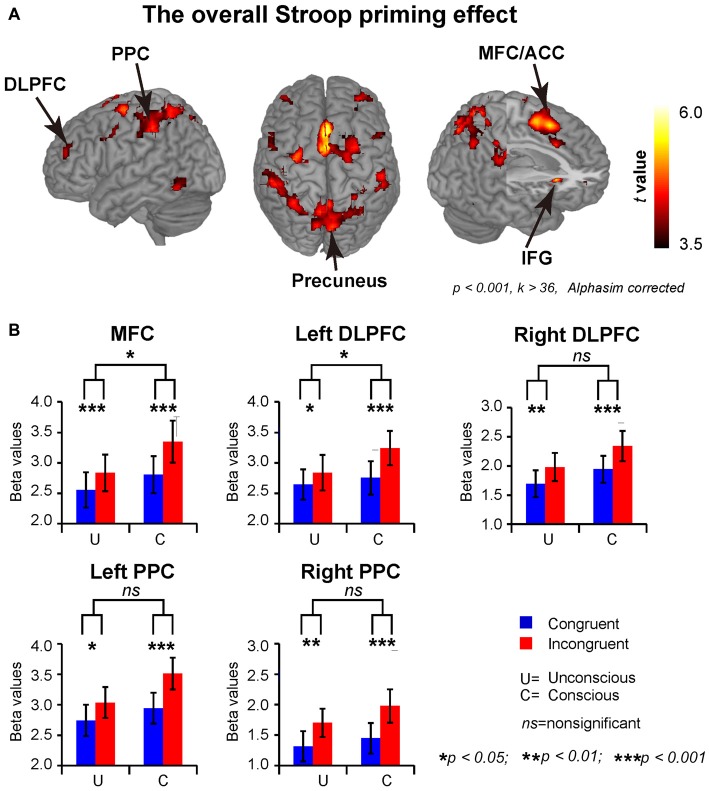
Brain regions showing significant activation of the overall Stroop priming effects. (A) The overall Stroop priming effects (Incongruent > congruent). The statistical thresholds were set at p < 0.001 with a minimum cluster size of 36 voxels using the AlphaSim Monte Carlo simulation. (B) The ROI analyses results. The Stroop prime effects were significant at MFC, left and right DLPFC, and the left and right PPC in both unconscious and conscious conditions, though the activations in conscious condition were stronger at MFC and left DLPFC than in unconscious condition. MFC, medial frontal cortex; DLPFC, dorsal lateral prefrontal cortex; PPC, posterior parietal cortex.